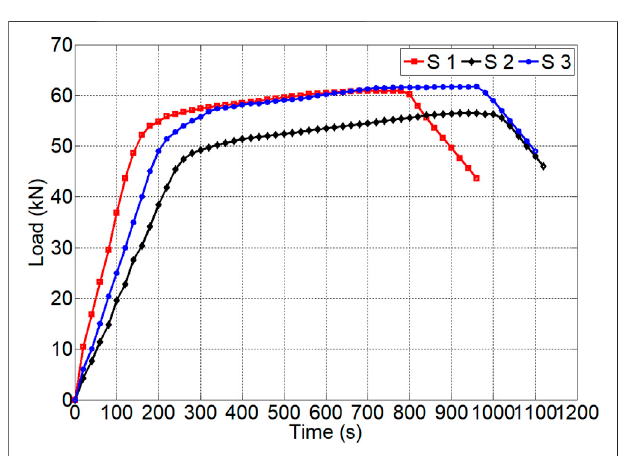
FIGURE 6 | Specimens after shear loading test.